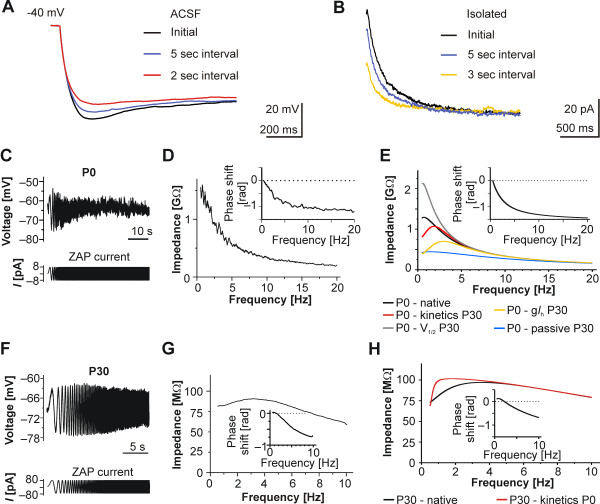
Functional implications and resonance behavior of layer V neocortical neurons at P0 and P30. (A) Varying the interpulse interval in the current-clamp between ‘infinite’ (initial), 2 seconds or 5 seconds reduced the sag amplitude as a result of the slowed deactivation. Depicted traces were recorded after injection of −50 pA. (B) Dependence of Ih activation and an instantaneous component on the interval of consecutive voltage steps to −130 mV of an ‘infinite’ (initial), 3-second or 5-second interval. (C/F) Examples of the membrane voltage of a neuron at P0 (C, top) and at P30 (F, top) as a response to ZAP current injection (bottom). Note the lack of a distinguishable peak despite the frequency increase to 20 Hz in P0 neurons. (D/G) Calculated impedance in relation to the frequency for the cells depicted in (C) and (F). Note the absence of a distinct membrane resonance peak and the relatively high impedance values at P0 (D) as compared to the distinct peak at approximately 3 Hz and lower impedance at P30 (G). At both age groups data points were averaged from three consecutive ZAP recordings. Insets: Impedance phase shifts in relation to the frequency. (E/H) Modeling (membrane voltage of −70 mV) using the entire parameter set for either a P0 or P30 neuron (black lines) mimicked the results of the ZAP recordings of rat neocortical neurons in brain slices. (E) Changing the kinetics to values of a P30 neuron (red line) or adjusting the conductance to a P30 neuron (yellow line) resulted in distinct resonance peaks, whereas replacement of the half-maximal activation by P30 values (grey line) or substituting the passive properties to values at P30 (blue line) led to massive impedance changes. (H) In contrast, replacing the simulation values at P30 by only the kinetic properties of a P0 neuron still resulted in a resonance peak, though less distinct (red line). Insets: Impedance phase shifts in relation to the frequency calculated from the simulated data. Only neurons at P30 showed a peak positive phase value and therewith a crossover from positive to negative phase in the impedance phase profiles.